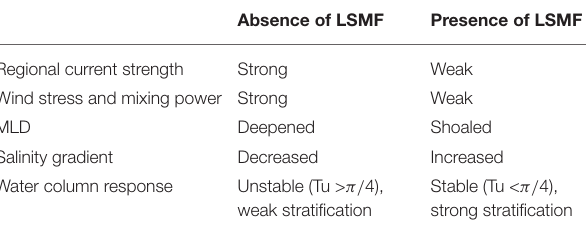
TABLE 4 | Summary table. Absence of LSMF Presence of LSMF Regional current strength